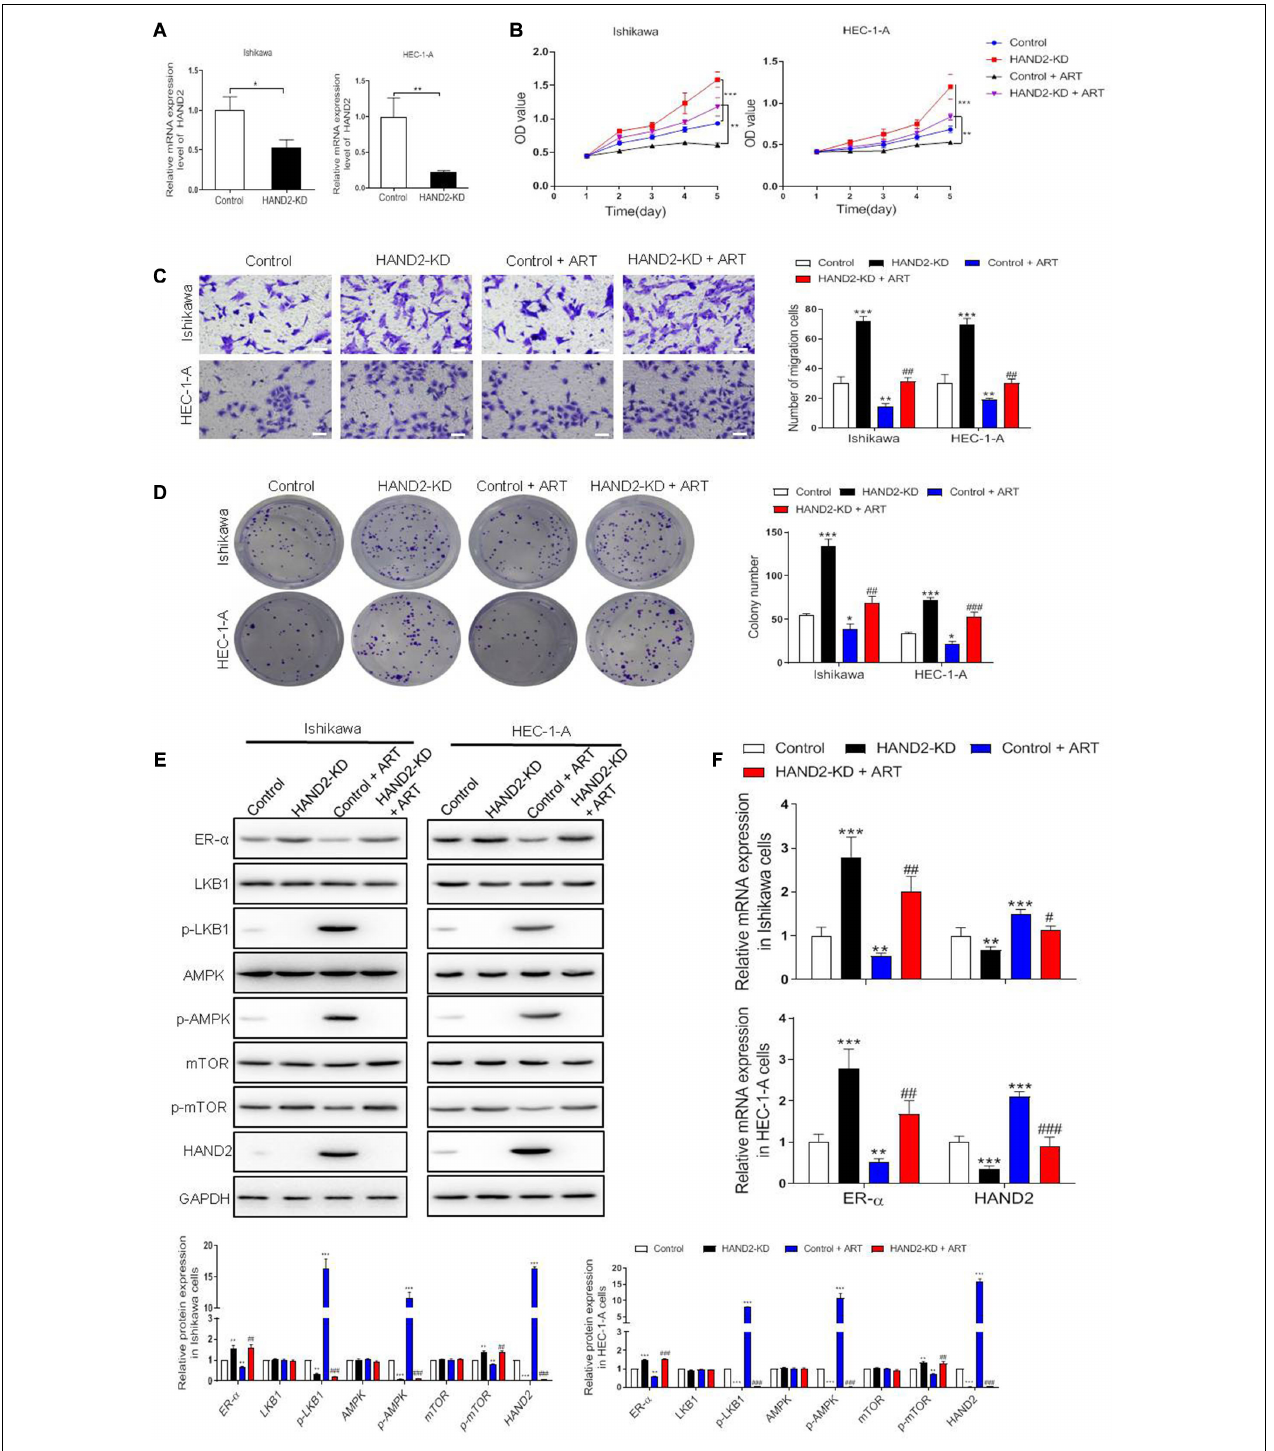
FIGURE 6 | Artesunate (ART) inhibited the proliferation of Ishikawa and HEC-1-A cells via the HAND2 dependent pathway. (A) The efficiency of HAND2 downregulated (HAND2-KD) vector transfection was assessed by qRT-PCR analysis. (B) Cell viability was assessed in these cells transfected with the Hand-KD vector in the presence or absence of ART (30 µ g/mL) treatment using CCK-8. ** p < 0.01, *** p < 0.001. (C,D) The migration and colony formation assays were performed in these cells after different treatments. Bar = 20 µ m. (E) Representative blot and analyses were performed for the protein levels of ER- α , LKB1, p-LKB1, AMPK, p-AMPK, mTOR, p-mTOR, and HAND2 in these cells. (F) The mRNA levels of ER- α and HAND2 were performed by qRT-PCR analysis. The data were showed as the mean ± SD, * p < 0.05, ** p < 0.01, *** p < 0.001 vs. the control group; # p < 0.05, ## p < 0.01, ### p < 0.001 vs. the control + ART group.